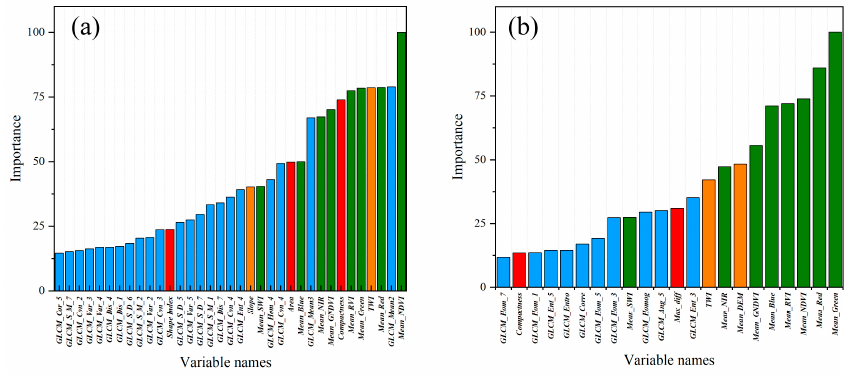
Figure 6. Input variables for scenario 4 using RFE algorithm. ( a ) GF-1 data, ( b ) ZY-3 data.